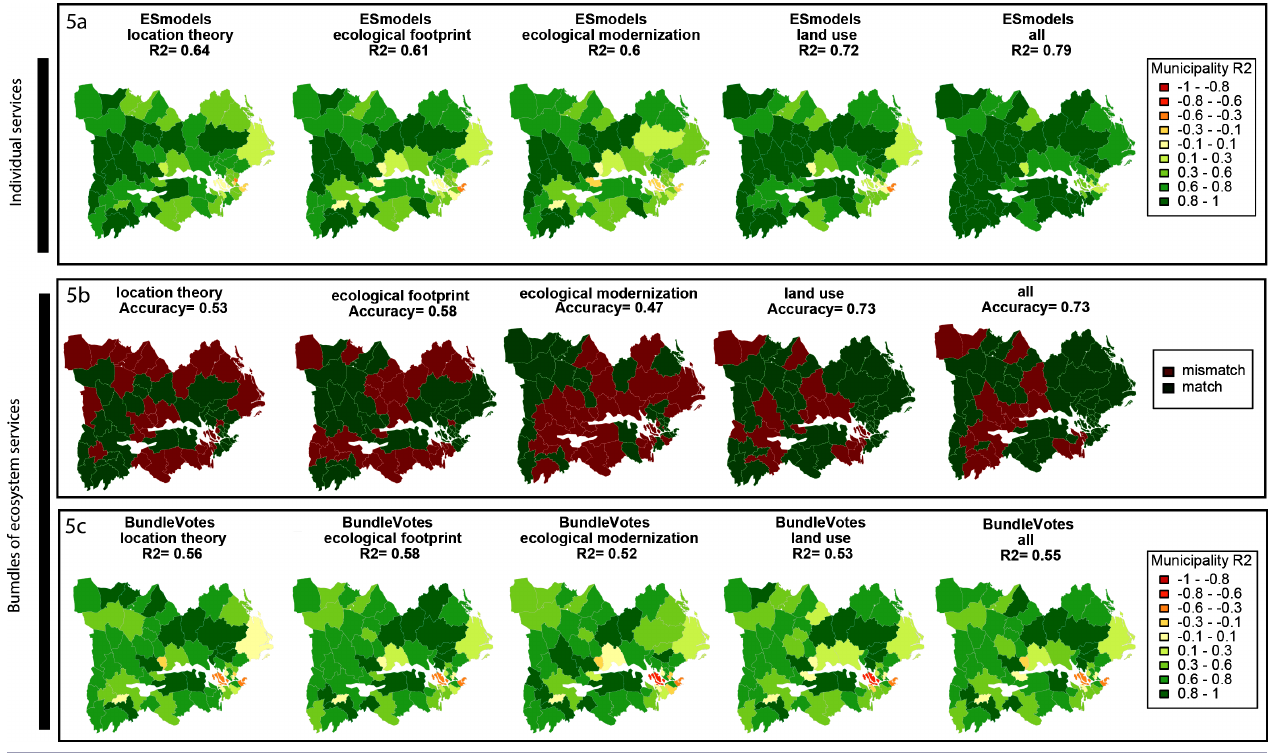
Fig. 5 . Relative ability of the models to predict individual services and bundles within municipalities across the Norrström drainage basin. 5a represents the gradient of accuracy in predicting the variation of individual ecosystem services within each of the 62 municipalities. The R² of predicted versus observed ecosystem services in each municipality is shaded from dark green (perfectly correct), to opposite (dark red). 5b shows which municipalities the models correctly (match) and incorrectly (mismatch) predicted the ecosystem service bundle. 5c represents the gradient of accuracy by each model by voting for bundle type (its weighted average of random forest support for each bundle multiplied by the average level of ecosystem services in each